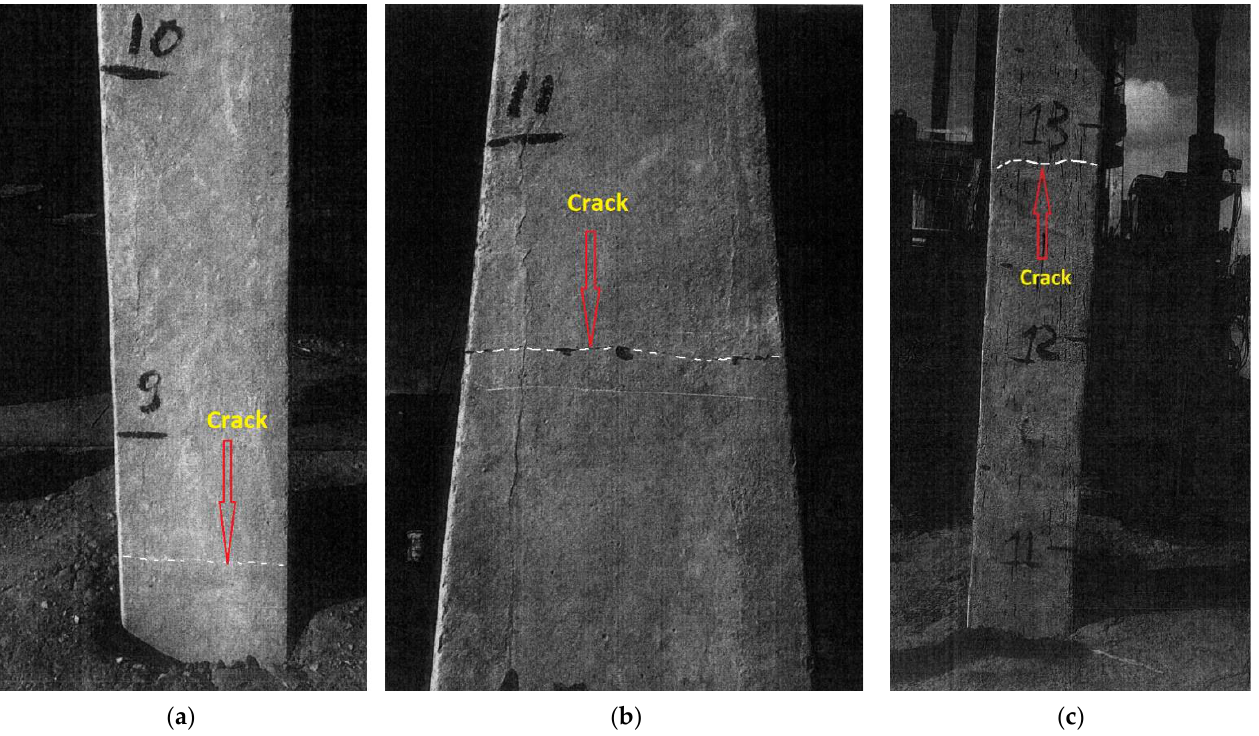
Figure 4. Cracks on Piles: ( a ) Pile 12HA 415, ( b ) Pile 12HA 415, and ( c ) Pile 12HA 174. Based on the analysis, the pile design was changed by increasing the number of reinforced cables from four to eight for each pile. The type of cable was unchanged, with a diameter of 15.24 mm, and a prestressing force of 19,200 kg (188.3 kN). The pile tensile strength was calculated using three approaches: (1) not accounting for the concrete tensile strength ( k = 0) as in most standards; (2) accounting for the concrete tensile strength